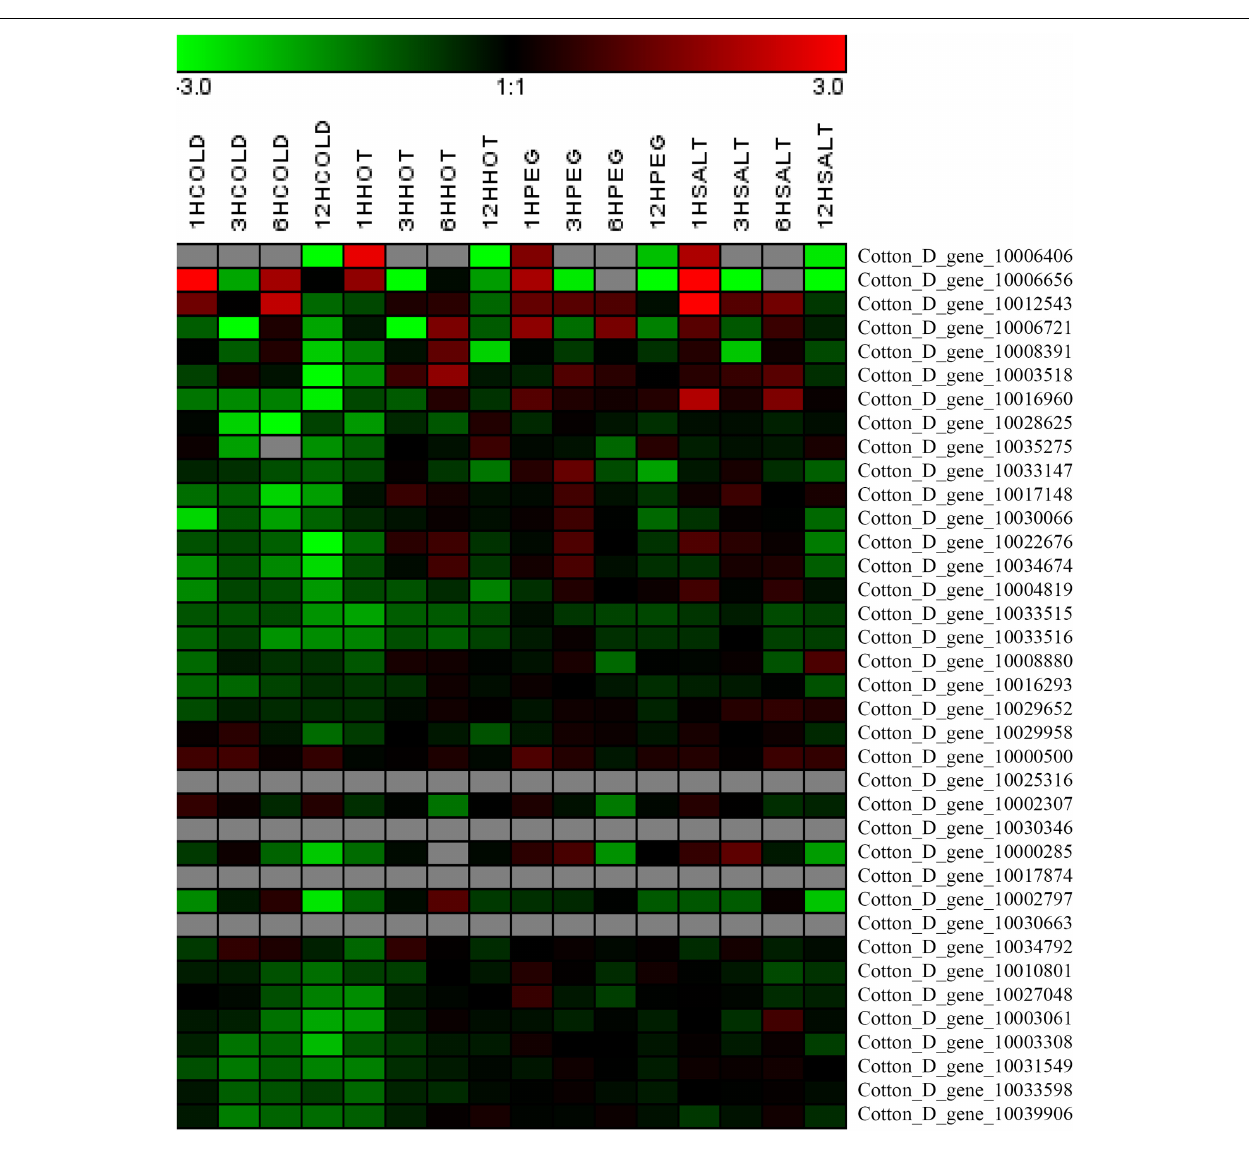
FIGURE 2 | Heat map representation for expression patterns of Gossypium raimondii TCP genes in cotton leaves under abiotic stress. The heat map, generated with Genesis, shows the hierarchical clustering of GrTCPs in response to cold (4 ◦ C), hot (37 ◦ C), drought (20% PEG) and salt (200 mM NaCl) stress, respectively. 1HCOLD, 3HCOLD, 6HCOLD, and 12HCOLD: cold treatment for 1, 3, 6 and 12 h; 1HHOT, 3HHOT, 6HHOT, and 12HHOT: hot treatment for 1, 3, 6, and 12 h; 1HPEG, 3HPEG, 6HPEG, and 12HPEG: drought treatment for 1, 3, 6, and 12 h; 1HSALT, 3HSALT, 6HSALT, and 12HSALT: drought treatment for 1, 3, 6, and 12